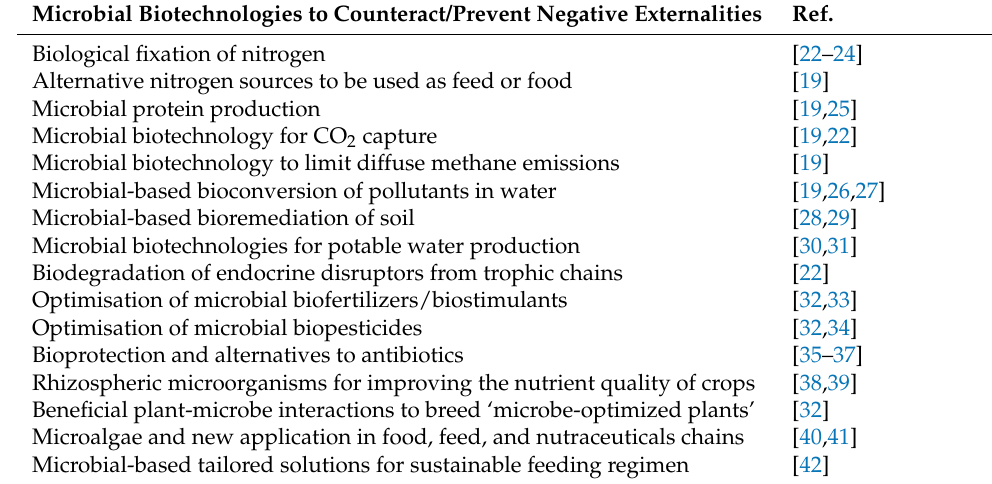
Table 2. A non-exhaustive list of possible microbial-based solutions as potential mitigating strategies against negative